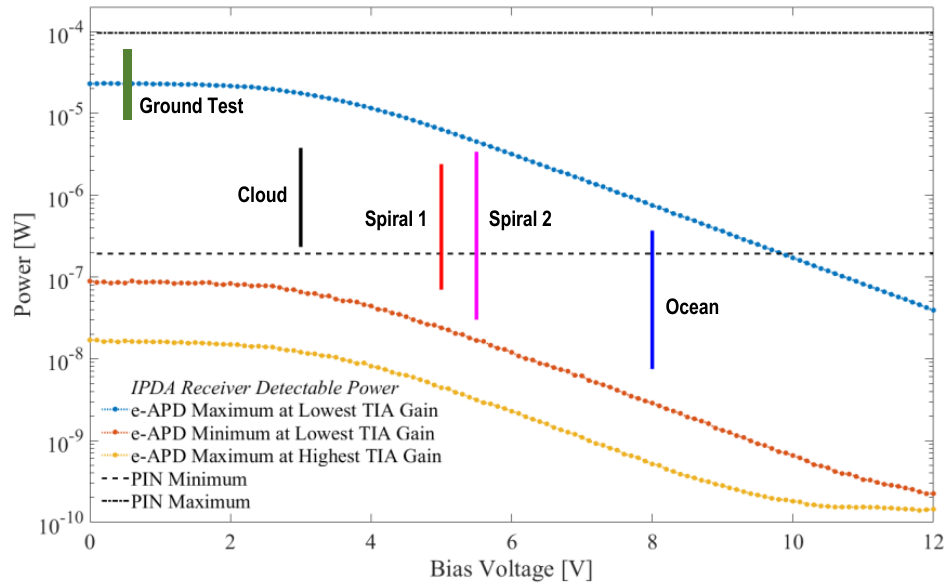
Figure 4. Dynamic range of the IPDA return power based on combining the high- and low-signal channels power limits, using PIN and e-APD detection systems, respectively. Dynamic range is defined by minimum and maximum detectable powers for steady operating conditions. At a fixed operating temperature of 77 K, dynamic range of the e-APD varies with the device voltage bias. Minimum power limit can be enhanced by setting TIA at higher gain. PIN is independent on bias voltage and included for comparison with e-APD. Vertical line mark return power range during September 17, 2019 flight for clouds (black), spirals 1 and 2 (red and purple) and ocean (blue) testing, as compared to ground testing (green) reported in [8].